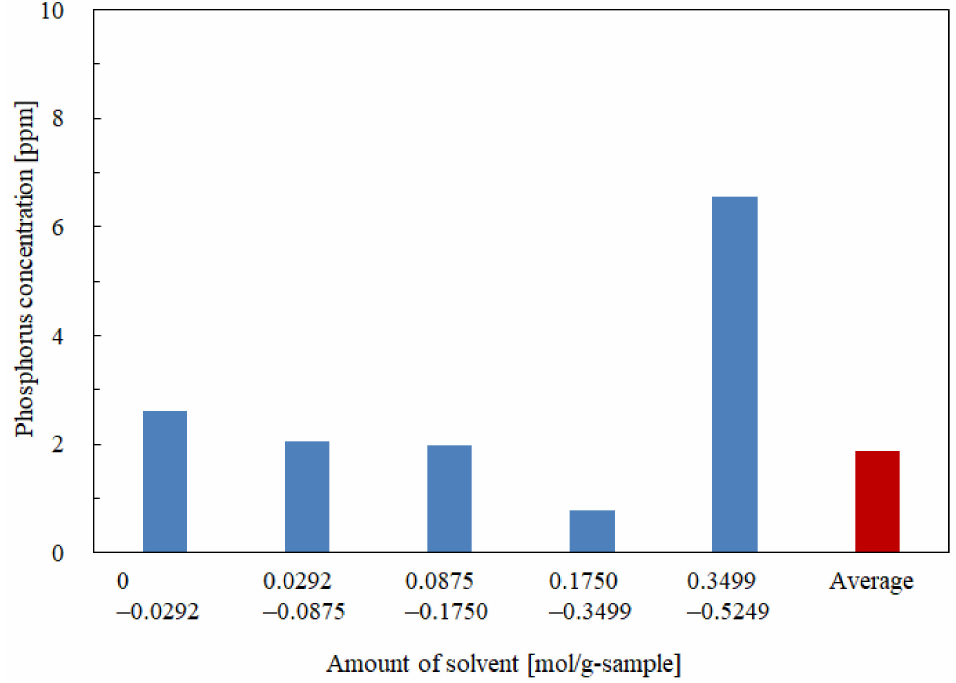
Figure 8. Influence of the amount of solvent on the phosphorus concentration in the oil extracted at